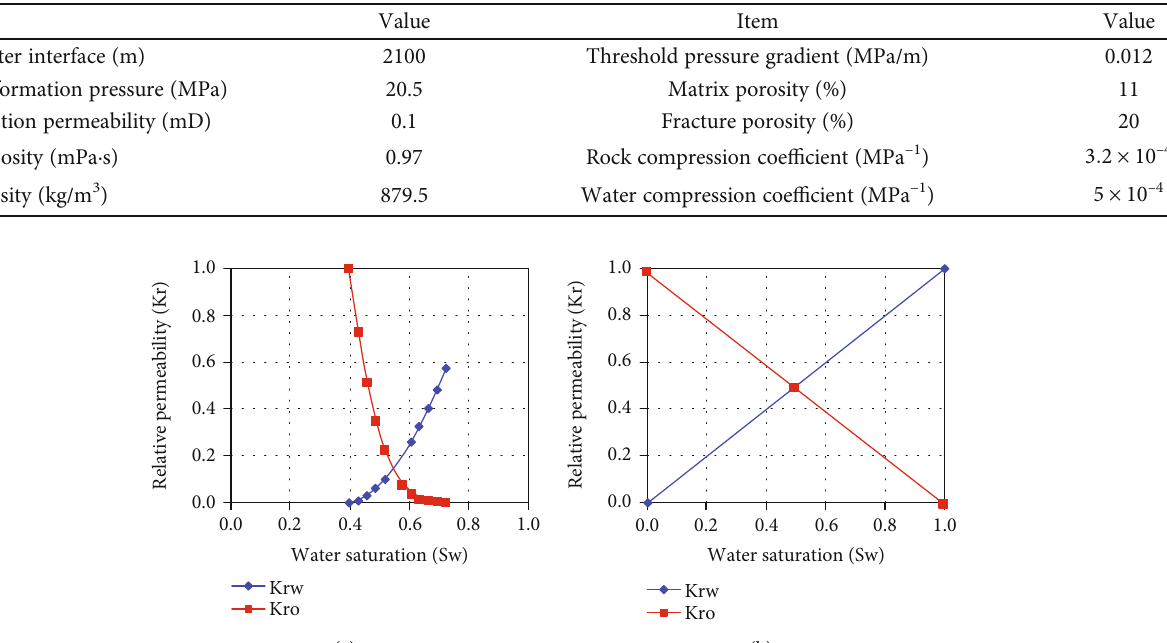
Table 1: Key simulation parameters used in the model.